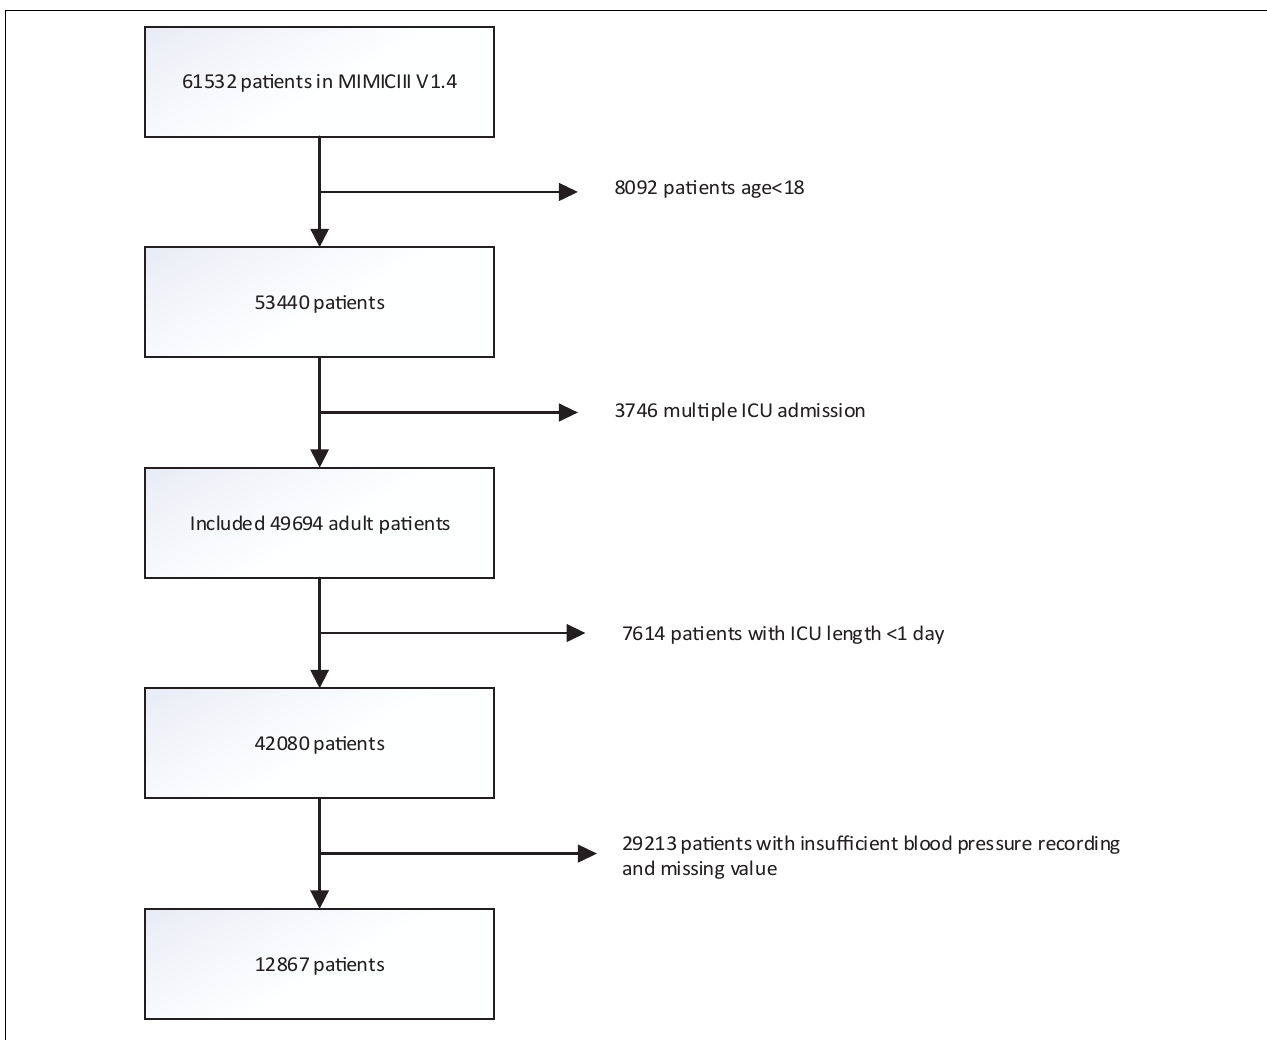
FIGURE 1 | Flowchart of participant selection. A total of 12,867 patients were included in the analysis. MIMIC-III, Multiparameter Intelligent Monitoring in Intensive Care